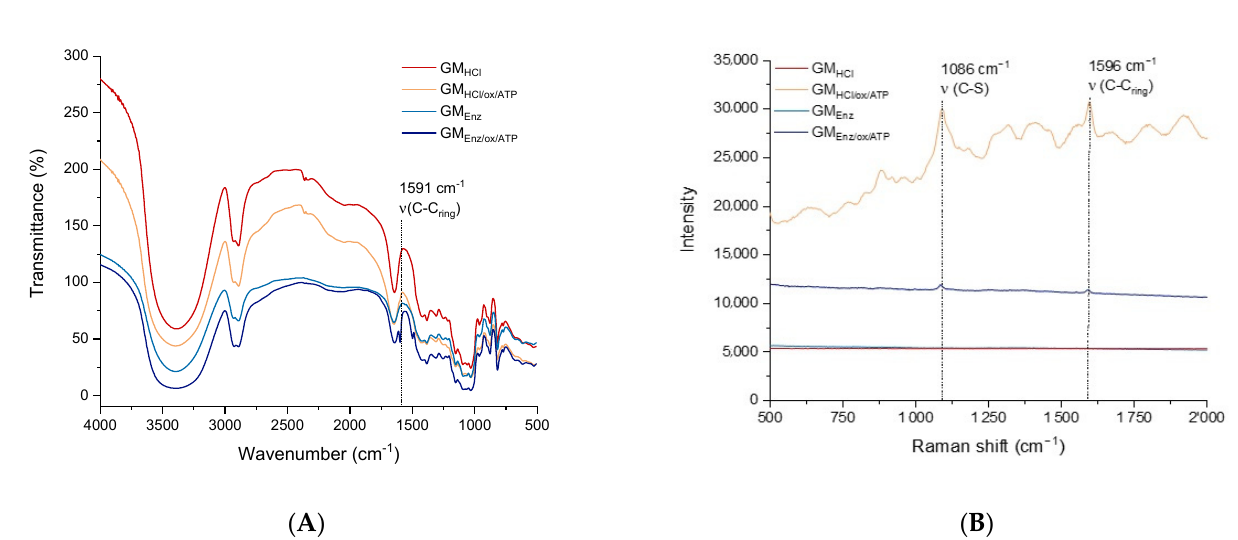
Figure 4. ( A ) FTIR spectra, and ( B ) Raman spectra of galactomannans before and after oxidation + reductive amination to the thiolated product.